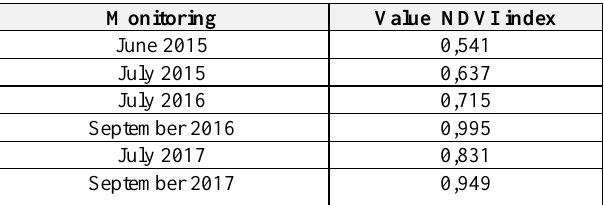
Table 3. NDVI indexes of monitoring